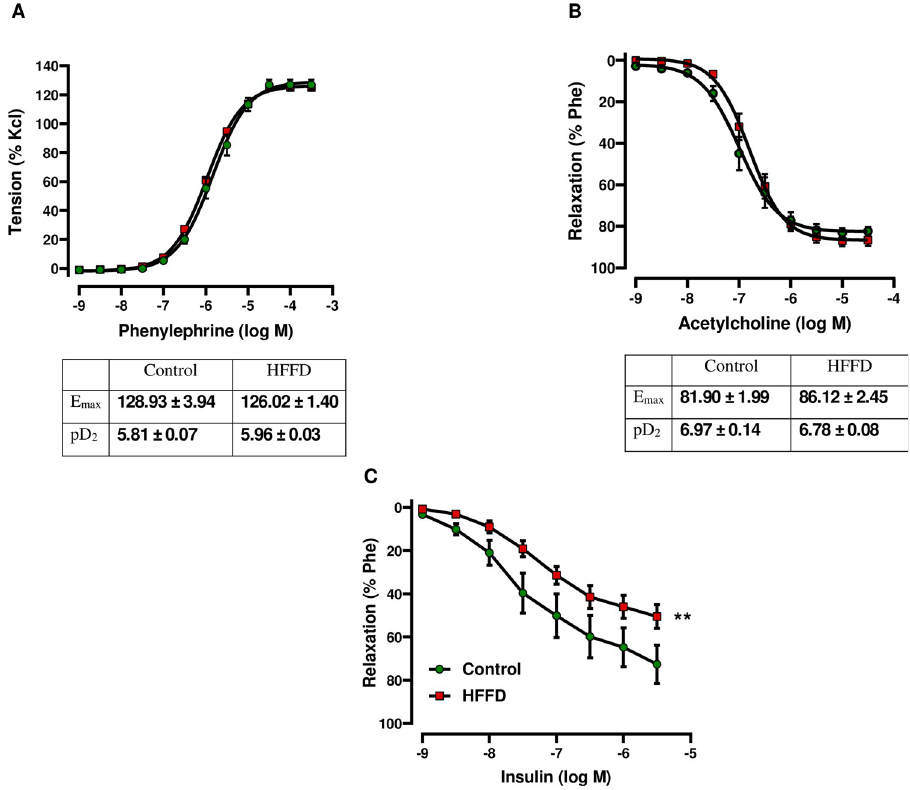
Fig 3. Effect of HFFD feeding on carotid vasoreactivity. CCRCs to (A) Phe, (B) Ach and (C) Ins were used to assess the vascular reactivity. (A) Carotid contractile response was evaluated using Phe (10 − 10 to 3.10 − 5 ). Meanwhile, relaxant responses were assessed by constructing CCRCs to: (B) Ach (10 − 9 to 3.10 − 5 M) and (C) Ins (10 − 9 to 3.10 − 6 M) on Phe- precontracted carotid rings. The calculated contraction and relaxation percentages are relative to the maximal changes from KCl (contraction) and Phe (precontraction), respectively. Emax and pD2 represent the maximal contractile response and the potency, respectively. Data are expressed as mean ± SEM and analyzed using NLME for Phe and Ach and LME for Ins. � p < 0.05, �� p < 0.01 HFFD vs. Control (n = 9 for Control and n = 12 for HFFD).